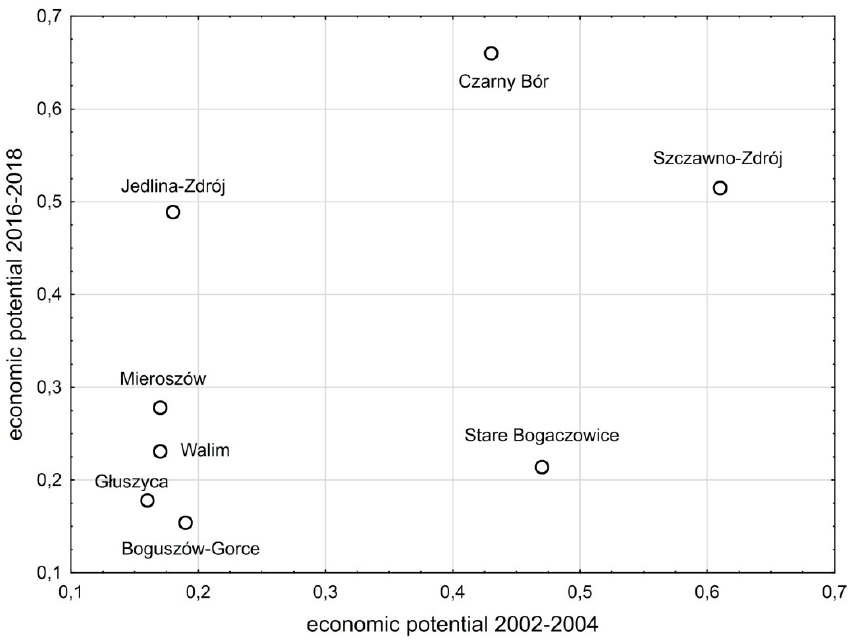
Figure 2. Scatter plot of economic development potential in 2002–2004 vs. 2016–2018. Source: authors’ compilation based on bdl.stat.gov.pl (accessed on 30 October 2020) [32].